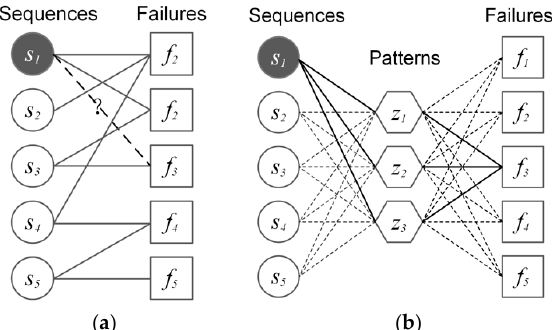
Figure 5. Schematic diagram of the matrix completion: ( a ) the graphical representation of the failure probability estimation task. The solid lines represent the existing observations, and the dotted line represents the probability of the estimate. ( b ) The model makes an estimation by the solid lines after matrix decomposition.